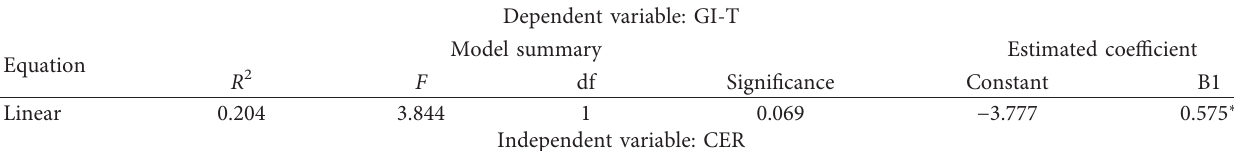
Table 6: Results of evolution relationship analysis on CER and GI-T.